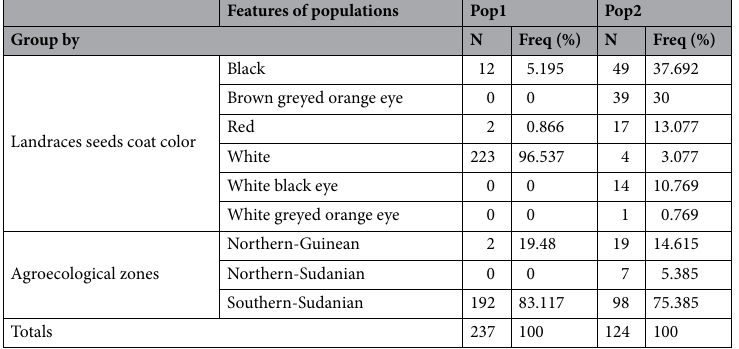
Table 1. Number (N) and proportions (Freq) of accessions for each genetic Group per Landrace and agroclimatic zone.